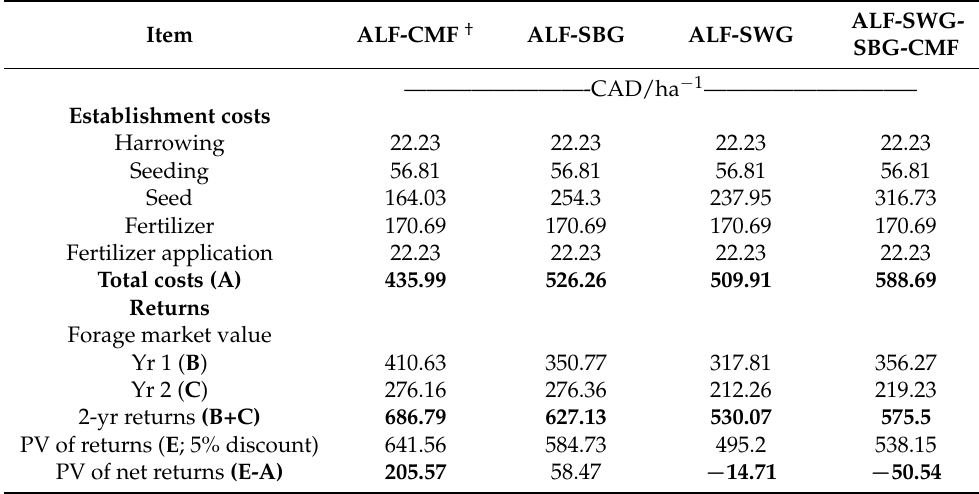
Table 8. Establishment costs and estimated present value of net returns for grass-legume forages seeded into saline soil in Clavet, Saskatchewan, Canada over 2